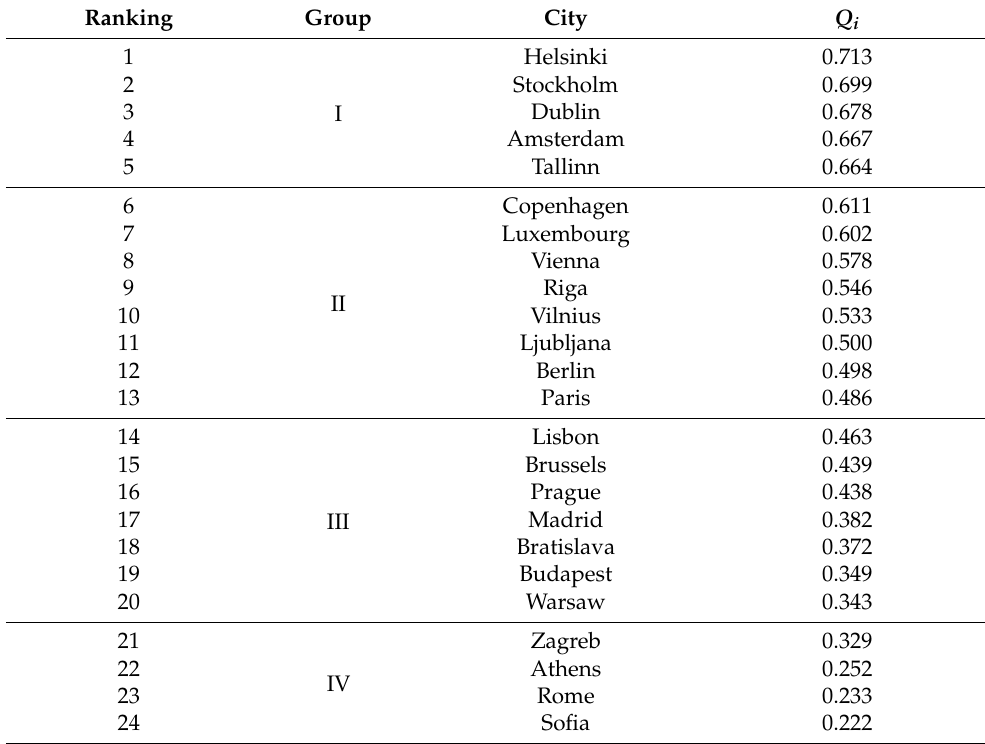
Table 2. Ranking of European Union capitals according to their level of environmental sustainability. Ranking Group City Q